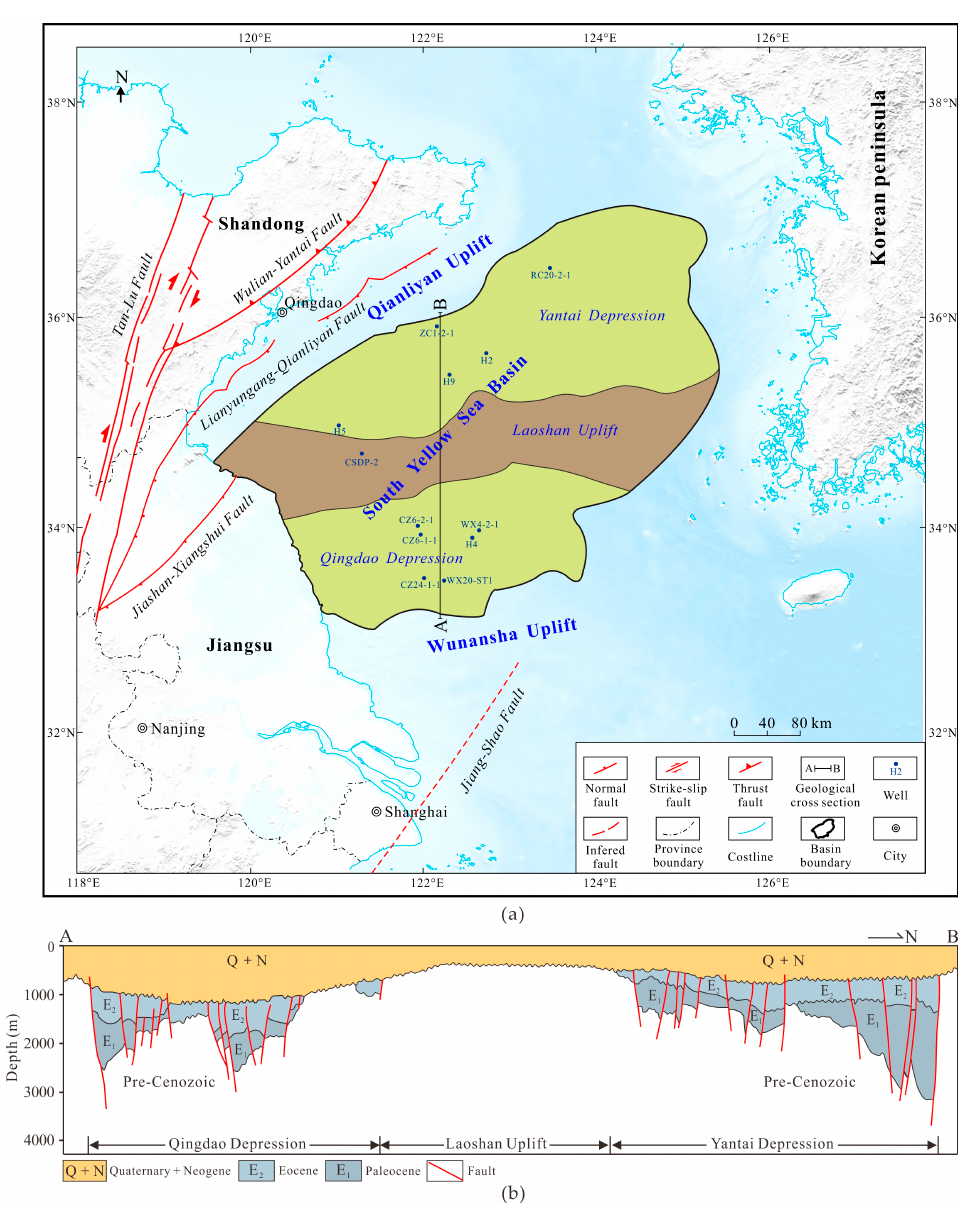
Figure 1. Map showing ( a ) the regional location of the South Yellow Sea Basin (modified from Chen et al. [47], and Yuan et al. [53]); ( b ) the geological profile of the Cenozoic strata in the South Yellow Sea Basin (see Figure 1 for the location of the profile).